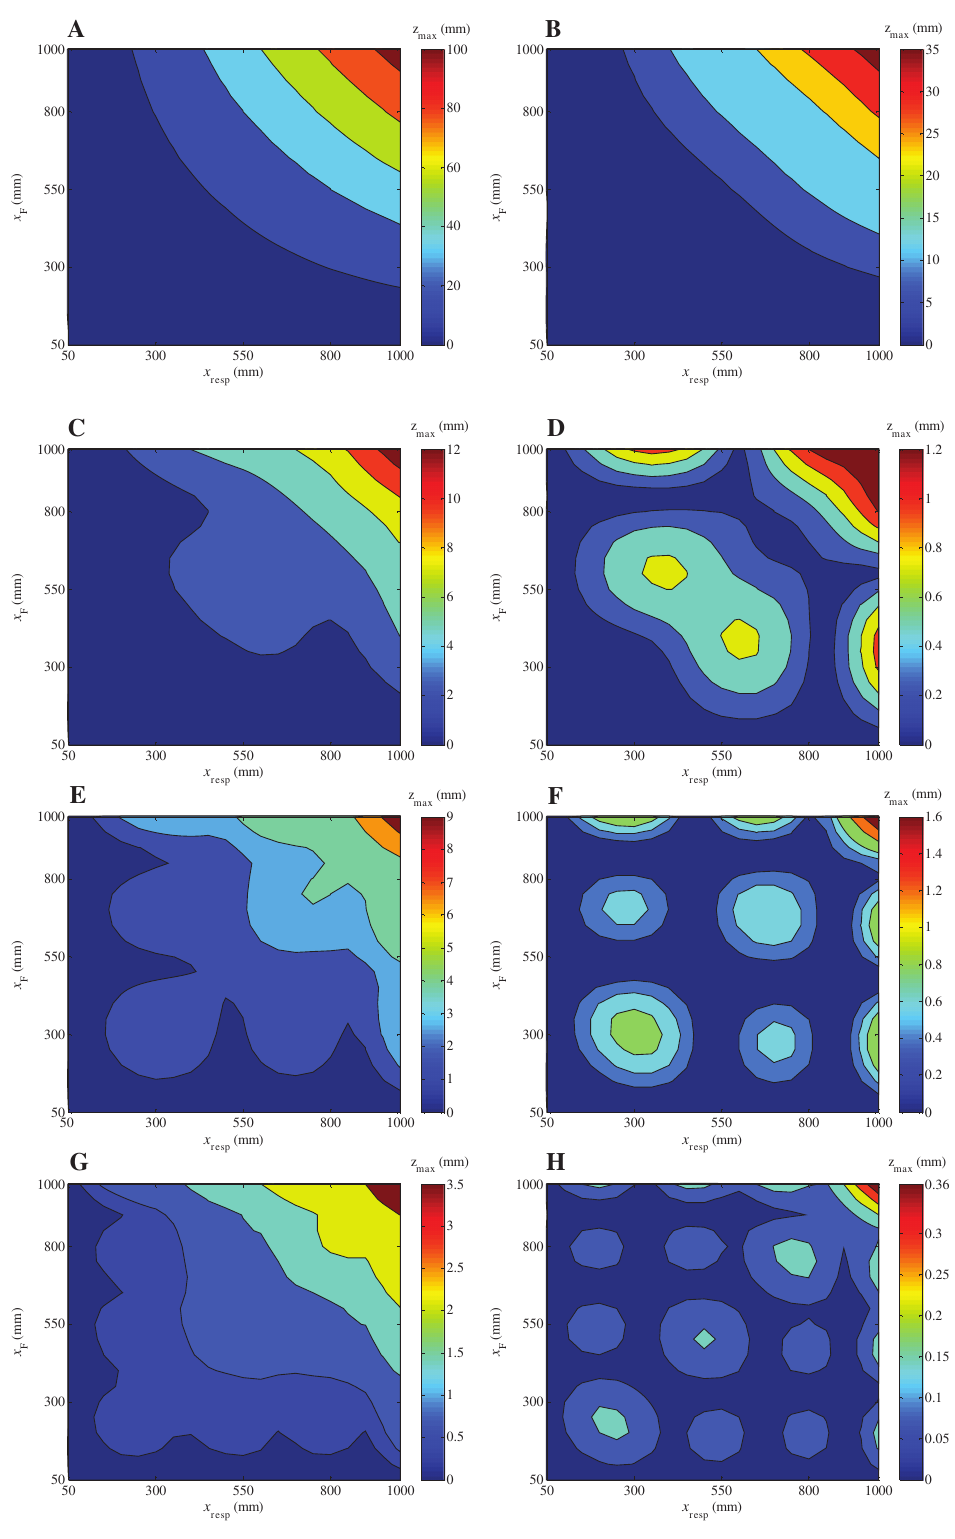
lay-up (A) 5 Hz, ζ = 0.0, (B) 5 Hz, ζ = 0.02, (C) 30 Hz, ζ = 0.0, s